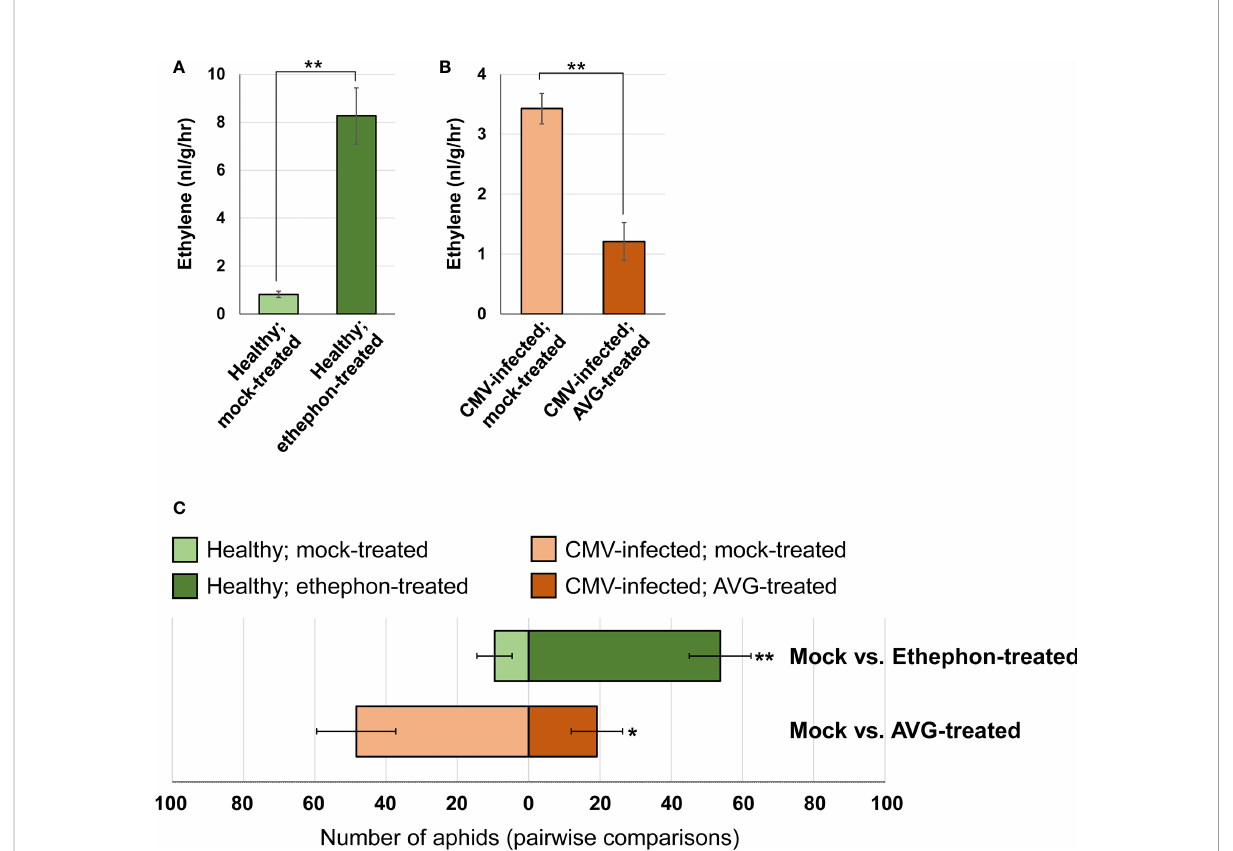
FIGURE 7 Effect of changes in ethylene emission on aphid attraction to pepper plants. (A) Ethylene emission by healthy pepper plants treated with mock or ethephon, as measured using gas chromatography. (B) Ethylene emission by CMV-infected pepper plants treated with mock or AVG, as measured using gas chromatography. The mean ± SD values from three independent experiments are shown, and each column represents one group with nine plants. Signi fi cant differences were determined using paired Student ’ s t -test (** P < 0.01). (C) Pairwise aphid preference tests between